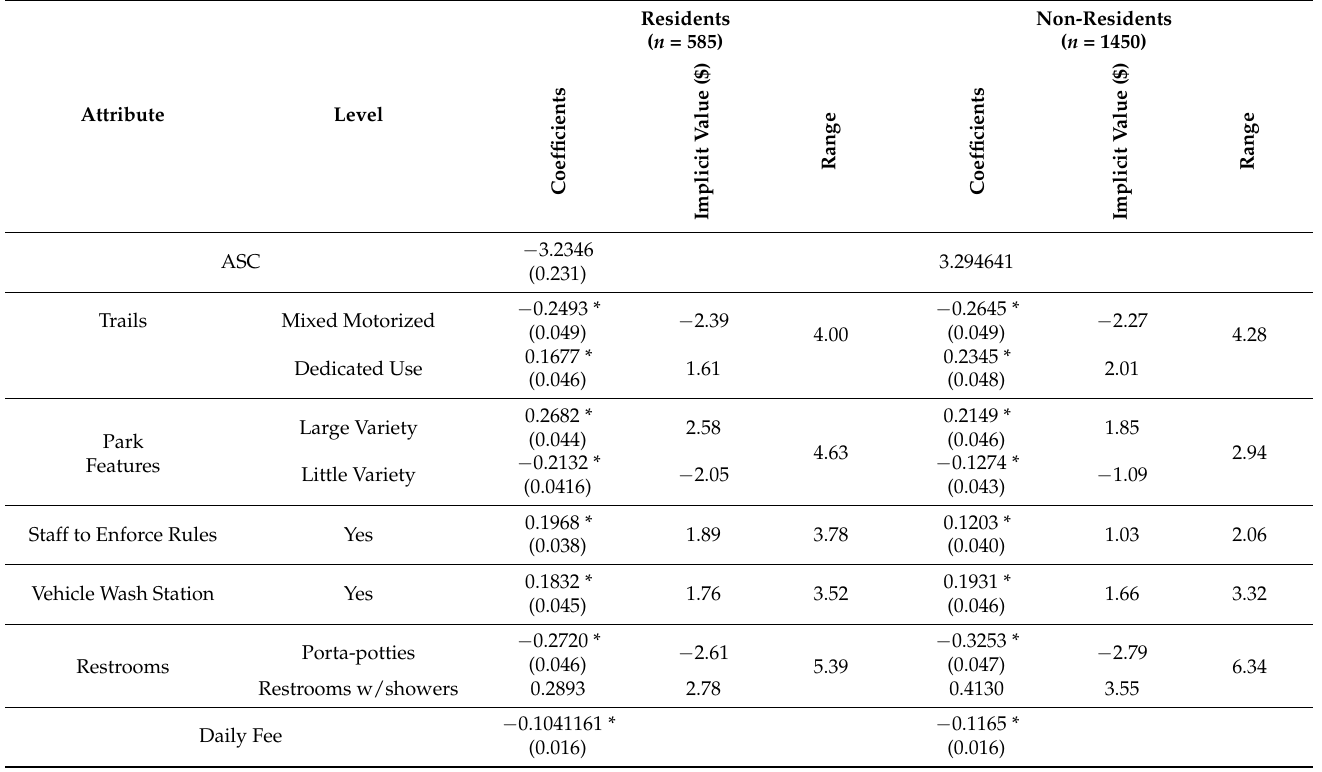
Table 4. Summary of choice model findings for residents and